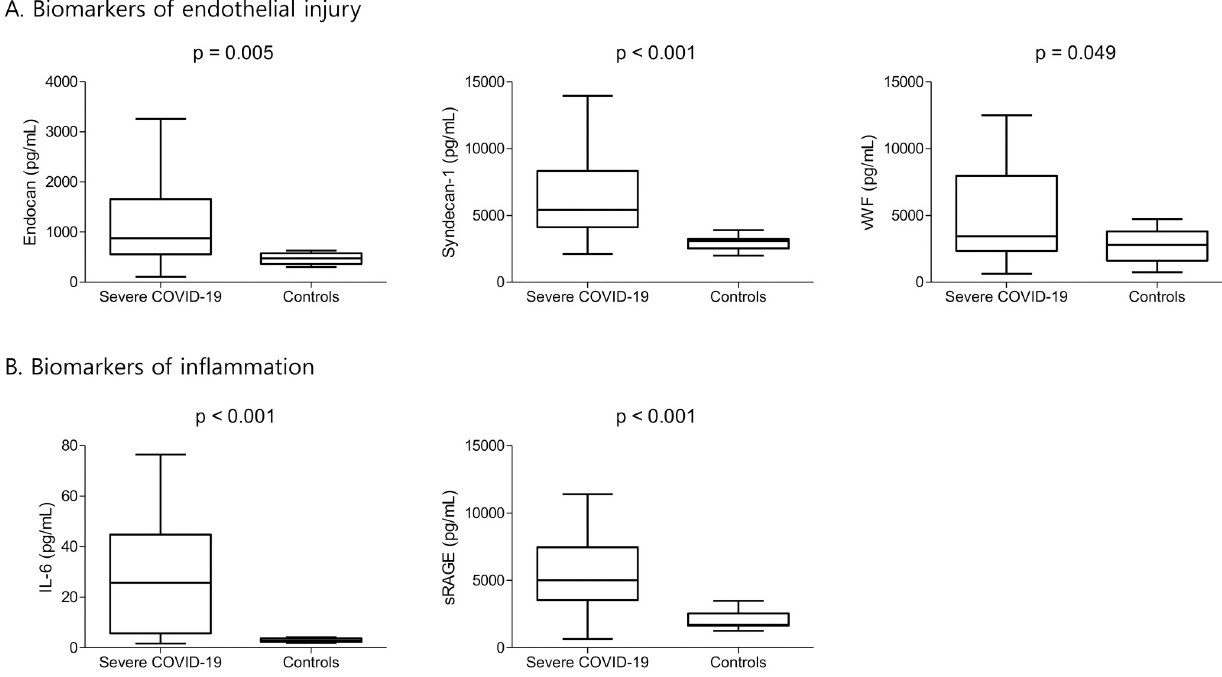
Fig 1. Plasma biomarkers of endothelial injury and inflammation in patients with severe COVID-19 and healthy individuals. Center lines represent the median values, the box tops and bottoms represent the interquartile ranges, error bars represent the overall ranges. COVID-19, coronavirus disease 2019; IL-6, interleukin-6; sRAGE, soluble receptor for advanced glycation end-products; vWF, von Willebrand